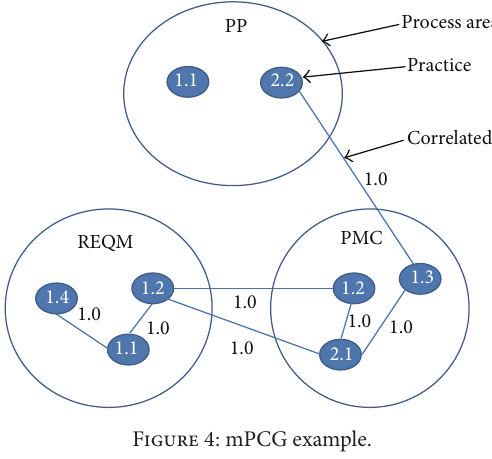
Figure 4: mPCG example.